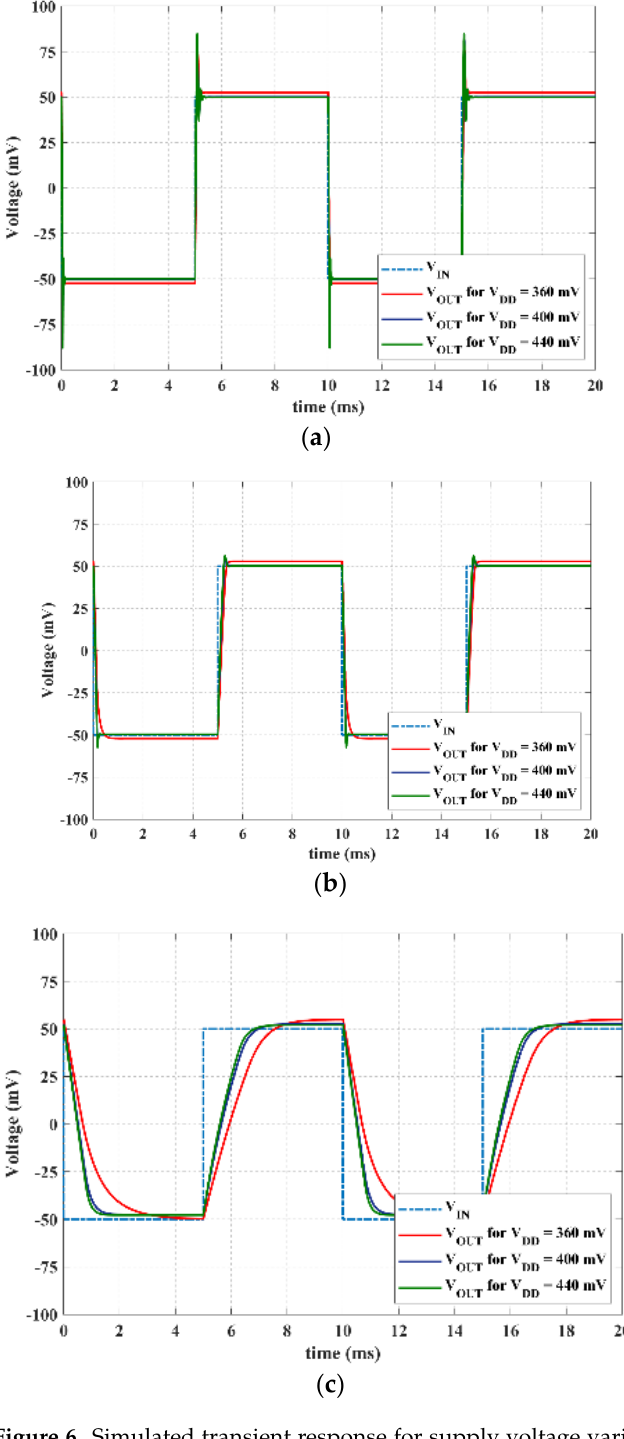
Figure 6. Simulated transient response for supply voltage variations of ±10% for: ( a ) C L = 30 pF, ( b ) C L = 150 pF and ( c ) C L = 1 nF.